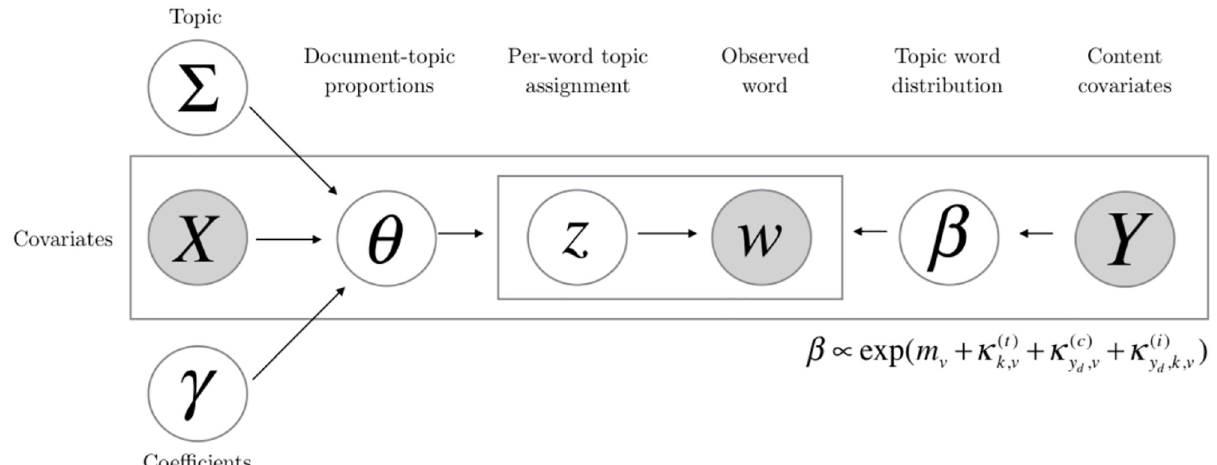
Fig 1. STM structural topic (adopted by Roberts et al.,